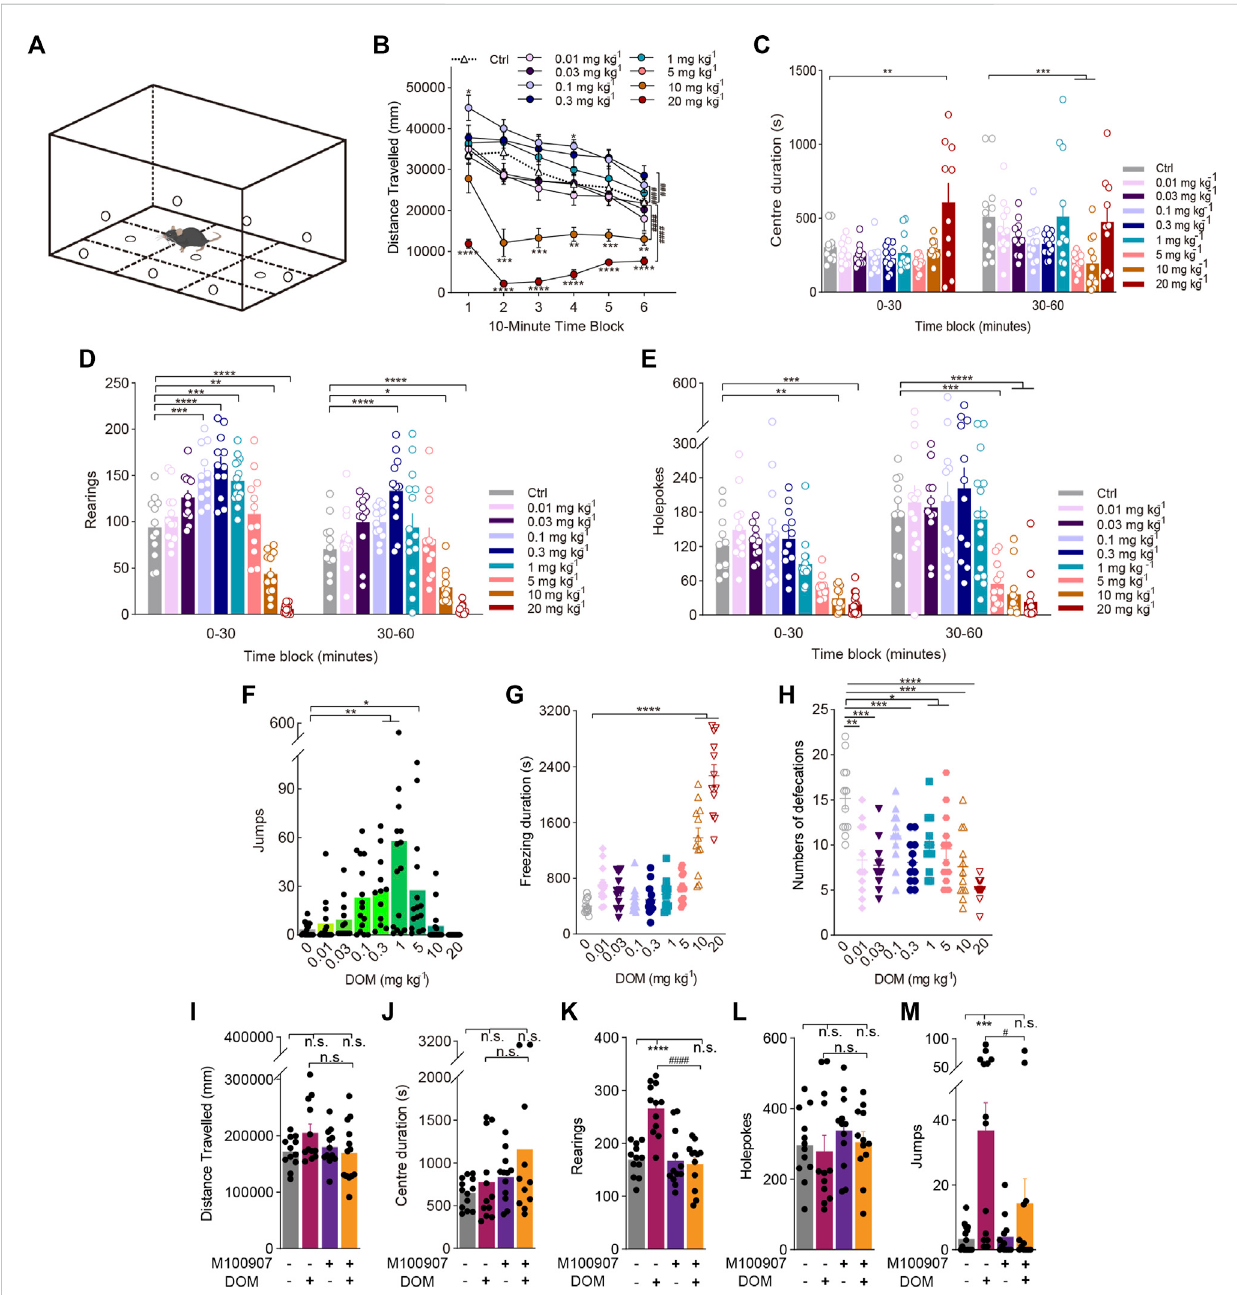
FIGURE 1 Behavioural changes in locomotor and exploratory behaviour of mice induced by the phenylalkylamine psychedelic DOM. (A) Schematic of the mouse BPM. Effect of DOM on (B,I) distance travelled (in mm), (C,J) centre duration (in seconds), (D,K) the total number of rearing behaviours ( rearings ), (E,L) the total number of hole explorations ( holepokes ), (F,M) the total number of jumps ( jumps ), (G) freezing duration (in seconds), and (H) the total number of defecations. Data are shown as the means ± SEM for consecutive 10-min (B) and 30-min intervals (C,D,E) . n = 12 – 15 mice per group. Statistical tests included two-way repeated-measures ANOVA comparing treatment groups to the control group at each timepoint (B) as well as, one-way ANOVA (G,H) , and two-way (B – E) ANOVA followed by Dunnett ’ s multiple comparisons test and Kruskal-Wallis H test with Dunn ’ s multiple comparisons test (F) . *p < 0.05, ** p < 0.01, *** p < 0.001, **** p < 0.0001, and ### p < 0.001, #### p < 0.0001, signi fi cantly different from the control group (A – H) . (I – M) Effect of pretreatment with the 5-HT 2A antagonist M100907 (1 mg/kg DOM +0.01 mg/kg M100907). n = 12 – 15 mice per group. Data